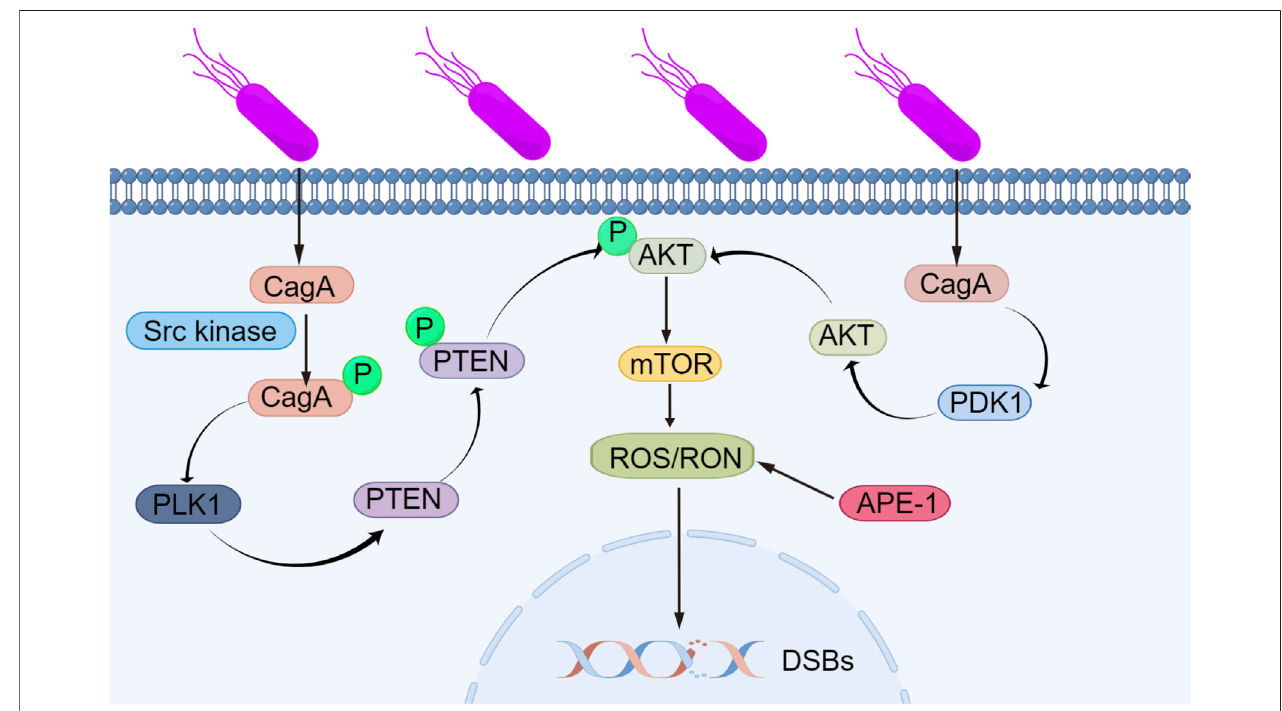
FIGURE 2 | Mechanism by which Helicobacter pylori induces DNA damage, leading to genomic instability. Helicobacter pylori can express the virulence factor CagA, which is recognized by cells and phosphorylated via Src family kinases. Phosphorylated CagA affects the expression of PLK1, leading to the phosphorylation of PTENandAKT,whileunphosphorylatedCagAinteractswithPDK1.TheactivationofAKTkinaseleadstosubsequentactivationofthemTORcomplex,producingROS/ RON, and the accumulation of RON/RON in cells causes DNA damage and genomic instability, leading to gastric